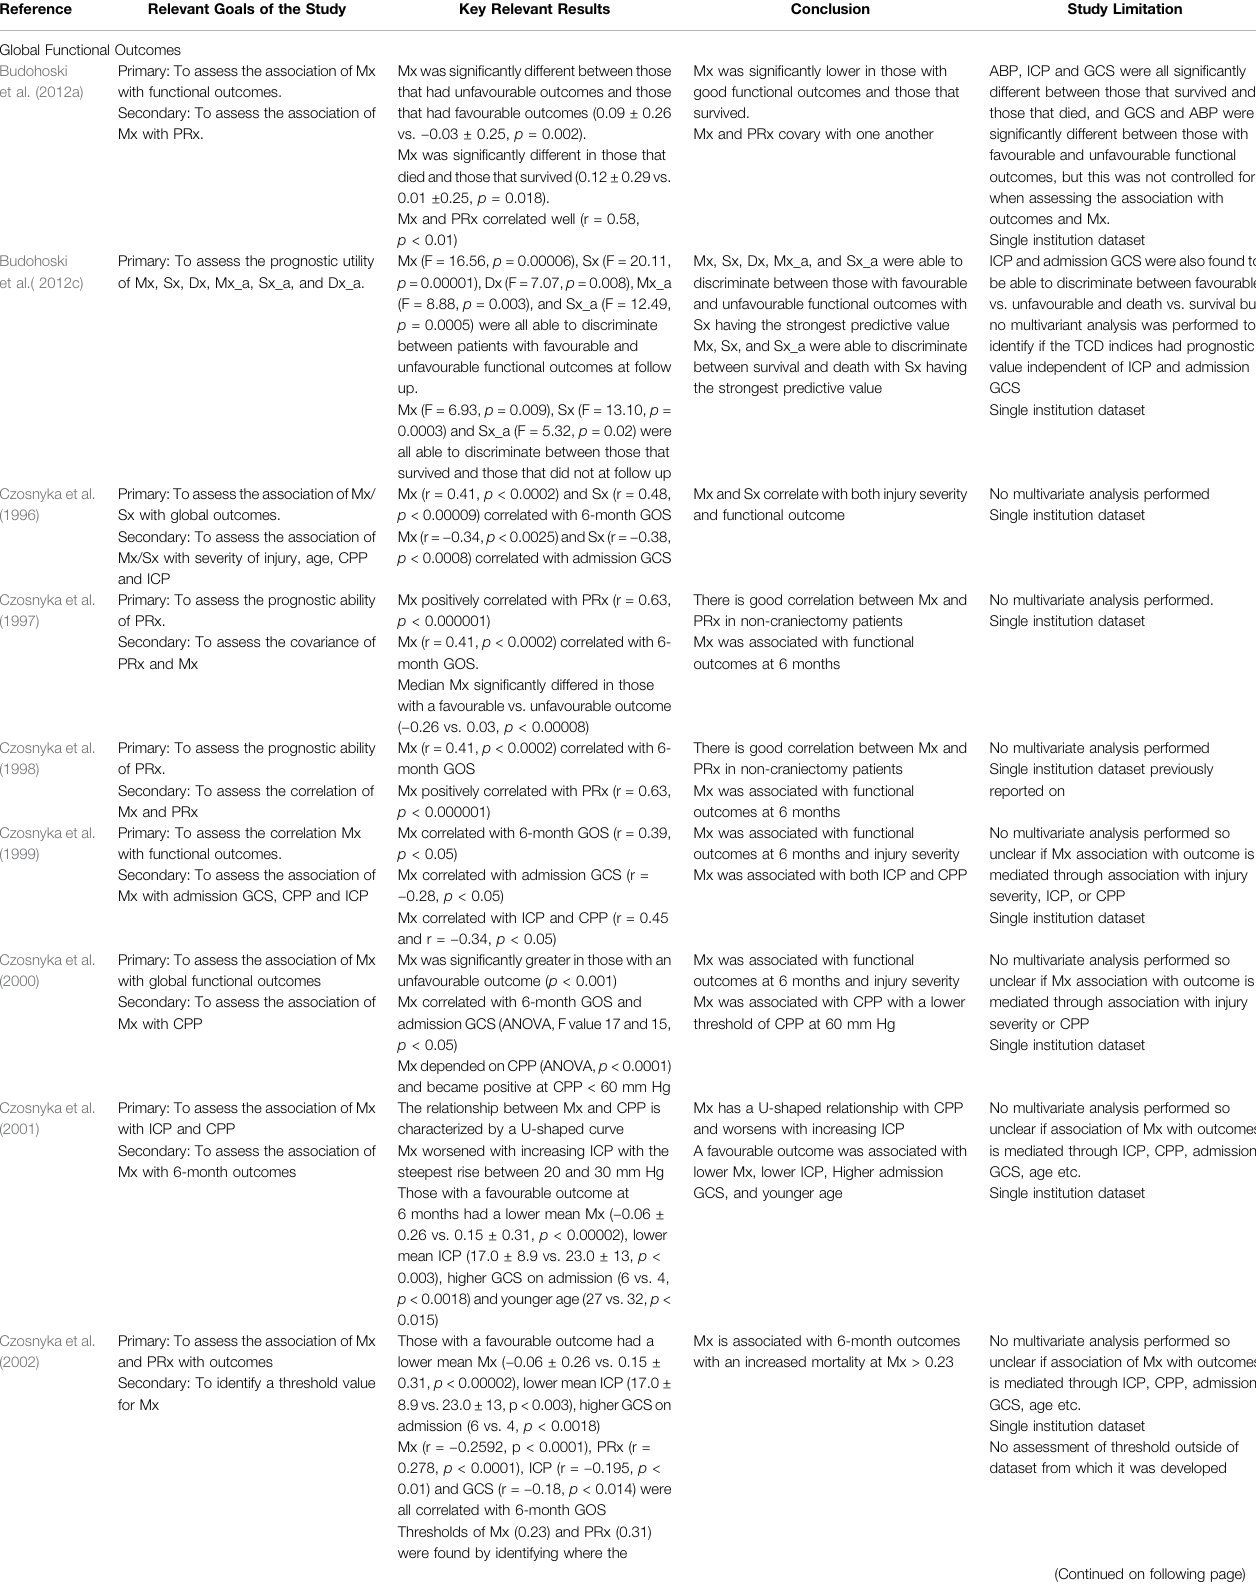
TABLE 4 | Study goals, fi ndings and limitations of included studies. Reference Relevant Goals of the